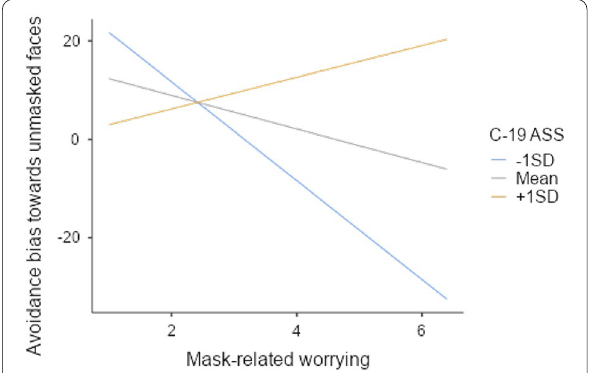
Fig. 1 Regression model estimates of avoidance bias based on mask-related worrying at varying levels of COVID-19 anxiety (C-19 ASS